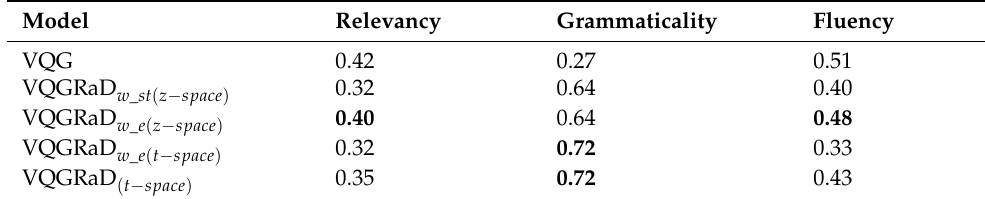
Table 5. Inter-rater reliability. We used F1-score to compute the inter-annotator agreement [62].